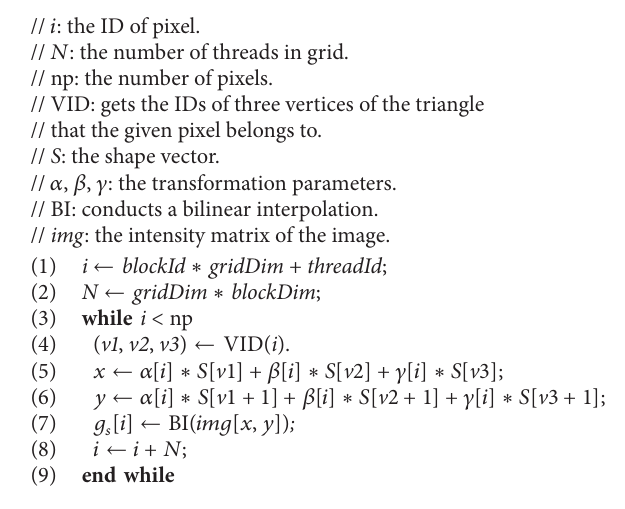
// 𝑖 : the ID of pixel.